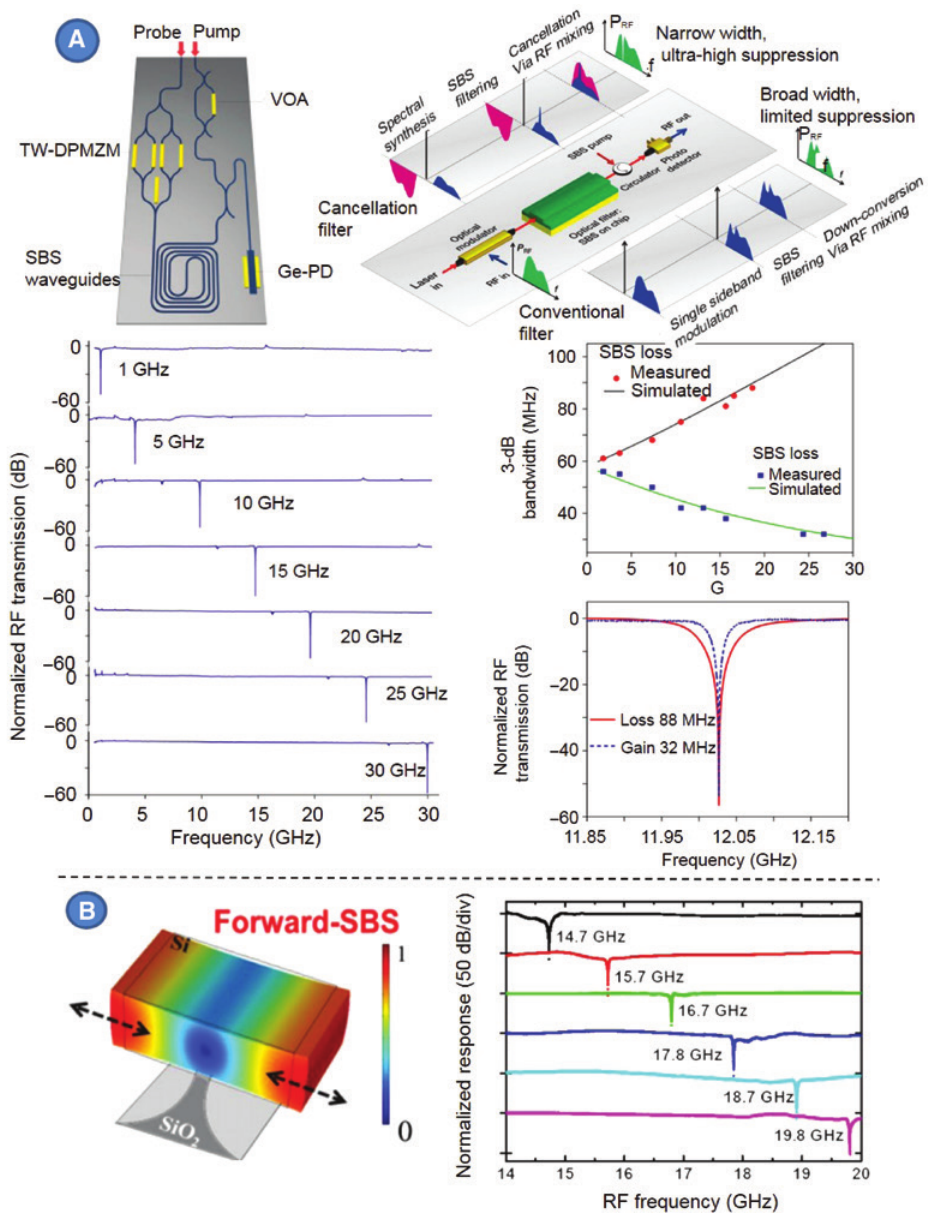
S waveguide and modulation spectrum 2 3